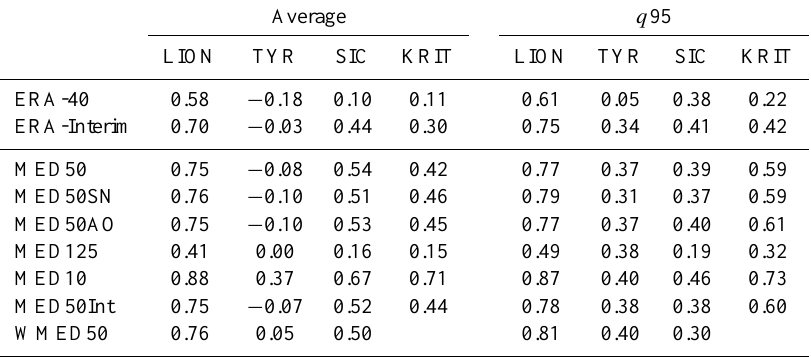
Table 5. Spatial correlation between QuikSCAT and respectively ERA-40, ERA-Interim and each ALADIN-Climate simulation over the four boxes shown in Fig. 1 of the average (left) and the 95th percentile (right) of the wind speed over 2000–2001. Average q 95 LION TYR SIC KRIT LION TYR SIC KRIT 0.58 −